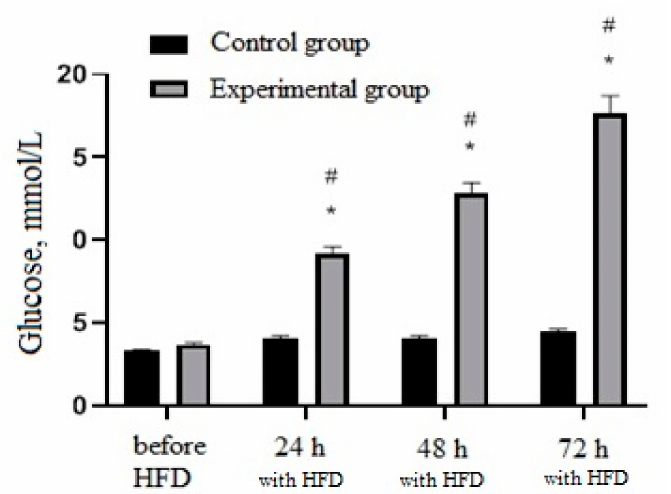
Figure 5. Animals blood-glucose levels measured 24, 48 and 72 h after administration of STZ (35 mg/kg). * Significantly different from the period prior to administration of STZ; # significantly different from the control